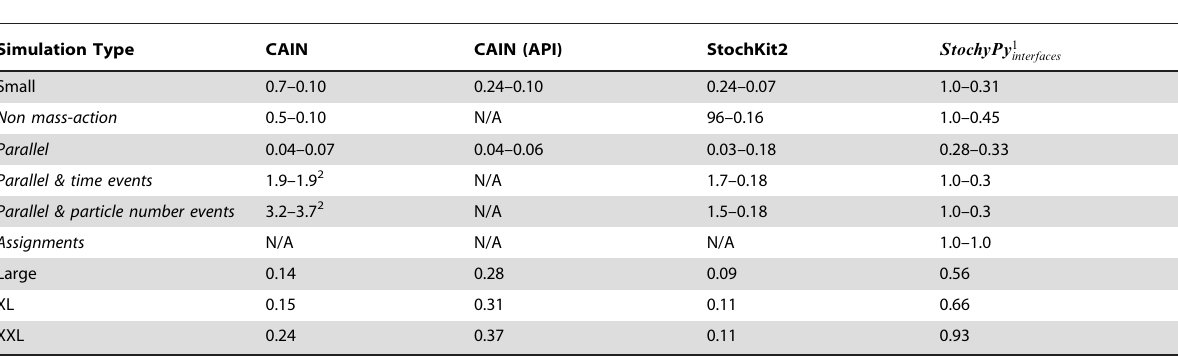
Table 2. Speed performance benchmark between StochPy and existing (stochastic)